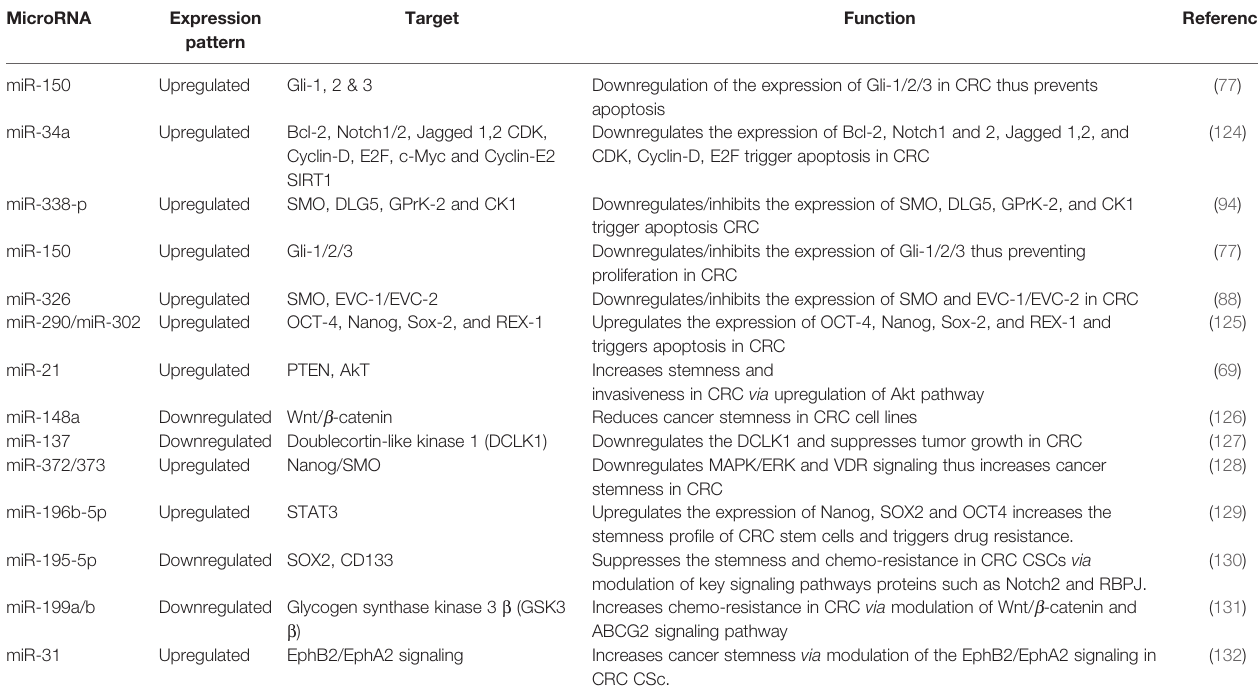
TABLE 1 | MicroRNA mediated control of CRC stemness and progression.